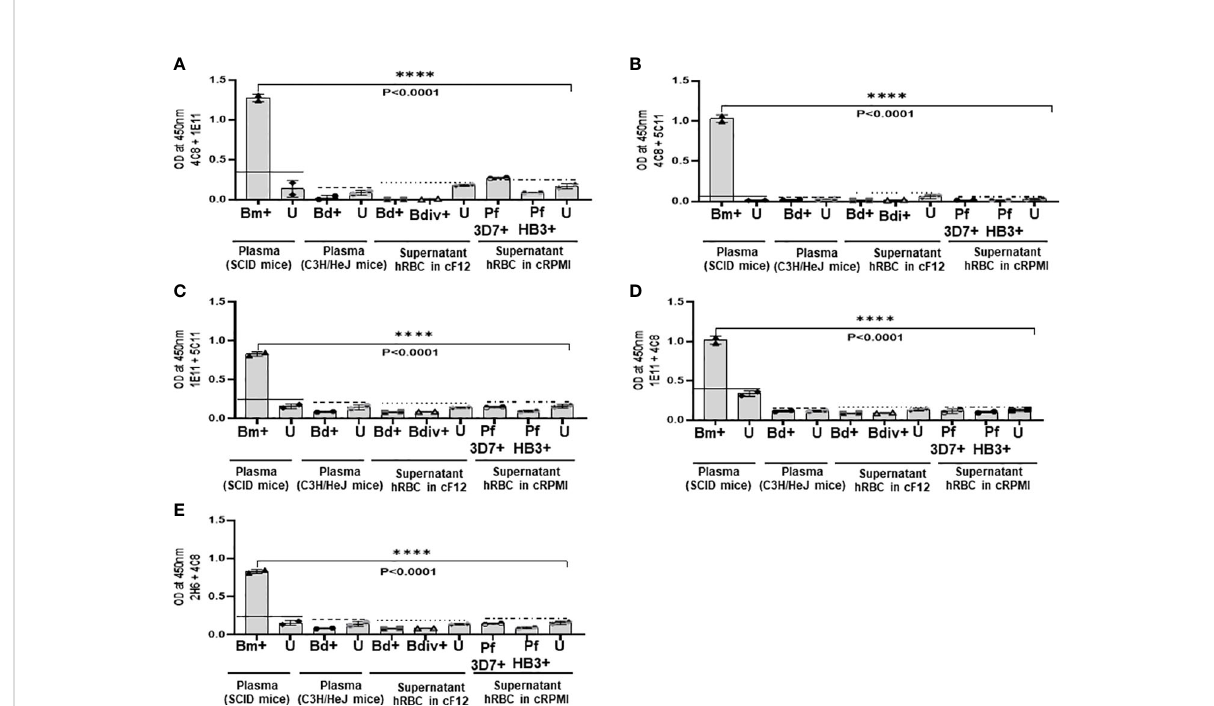
FIGURE 10 Speci fi city of the mGPAC assay. Antigen capture assays with different combinations (A – E) of anti-BmGPI12 monoclonal antibodies were conducted using culture supernatants from B duncani WA-1 (25% parasitemia), B divergens Rouen87 (10% parasitemia), P. falciparum 3D7 (10% parasitemia), and P. f alciparum HB3 (10% parasitemia)-infected human erythrocytes as well as heat inactivated plasma from uninfected or B duncani- infected C3H/HeJ mice (34% parasitemia). Plasma from B microti infected or uninfected SCID mice were used as positive and negative controls, respectively. Parasite cultures that were available in the laboratory at the time of the experiments were used. Error bars denote the standard deviation (SD) calculated using the Graphpad Prism 9.3 software. For each sample type, the OD 450 cut-off (dashed line) denotes the mean + 2 x SD of the OD 450 value of the corresponding uninfected sample. ****, statistically signi fi cant (p<0.0001, by one-way ANOVA). Bm, B microti ; Bd, B duncani ; Bdiv, B >divergens ; Pf, P. falciparum ; +: infected; U, uninfected; hRBCs, human red blood cells; cF12, complete DMEM- F12; cRPMI, complete